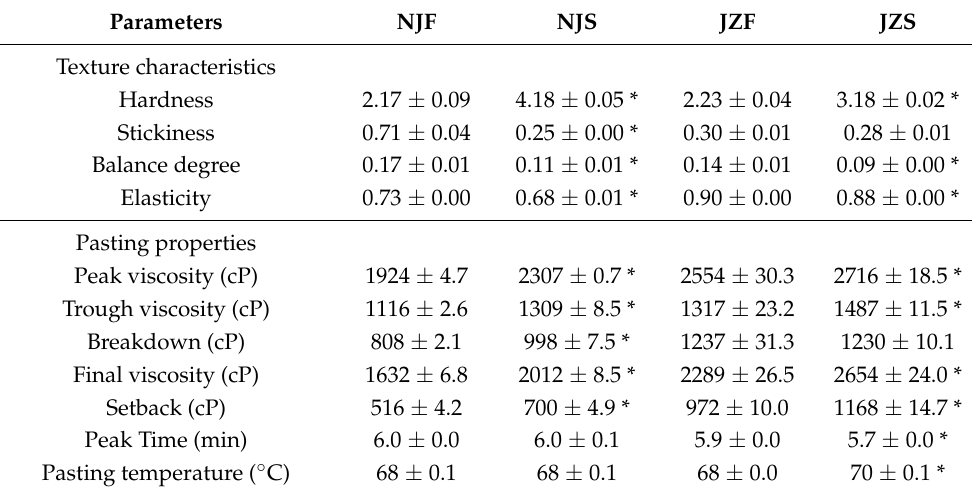
Table 1. Texture characteristics and pasting properties of NJ and JZ ( n = 3, α = 0.05).